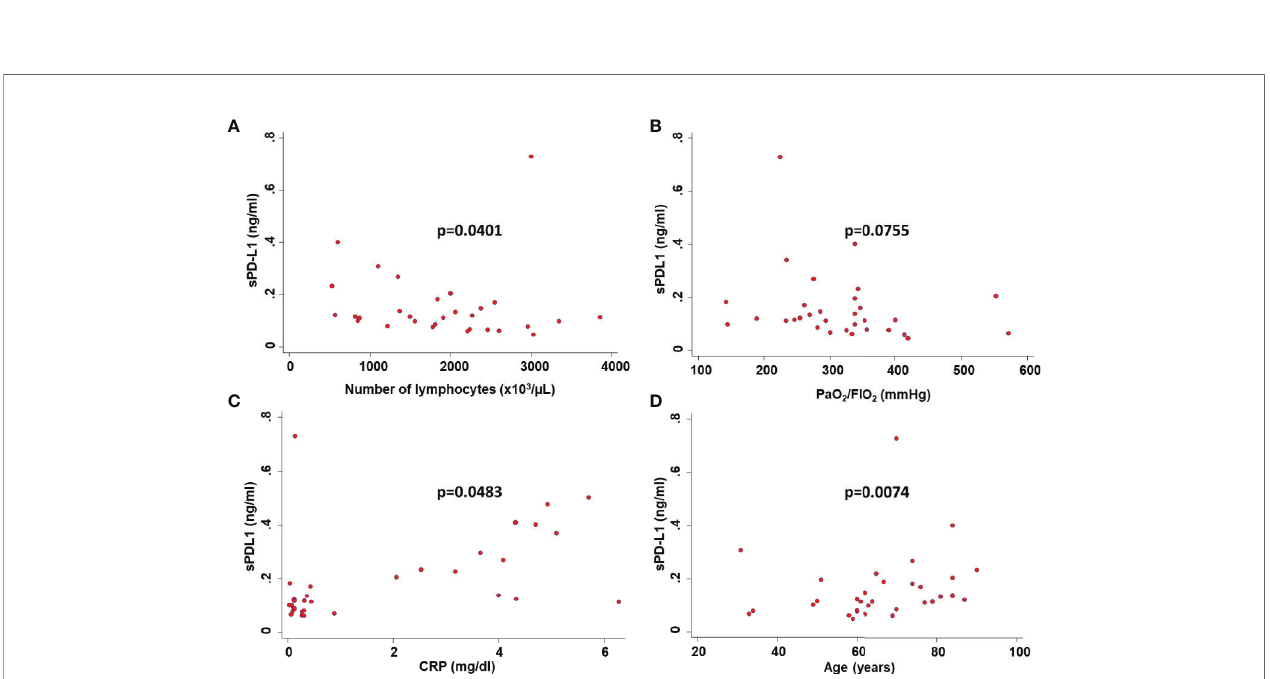
FIGURE 2 | Correlation between serum levels of sPD-L1 and clinicopathological characteristics of COVID-19 patients. Serum levels of sPD-L1 in COVID-19 patients were correlated with the number of peripheral lymphocytes (A) , the level of PaO 2 /FIO 2 (B) , the level of CRP (C) and the age of patients (D) by Spearman ’ s correlations. p was considered signi fi cant if <